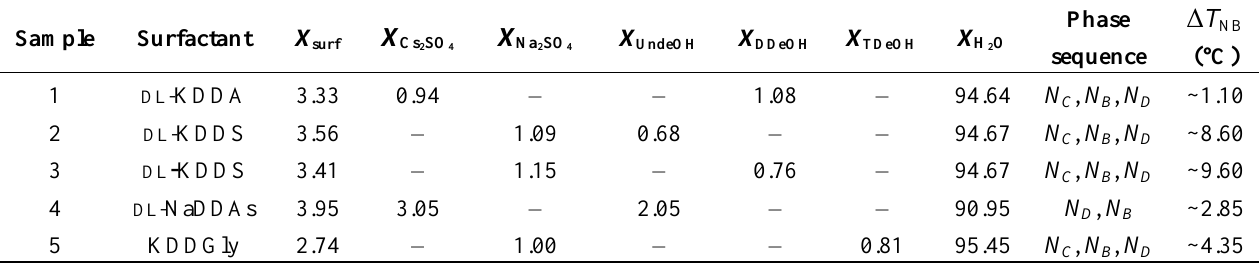
Table 2. Compositions of the mixtures investigated. The phase sequences correspond to the observed phases (from left to right, the temperature was increased). UndeOH, DDeOH and TDeOH are the alcohols, 1-undecanol, 1-dodecanol and 1-tridecanol, respectively. X is the mole percent fraction of each constituent. Δ T phase